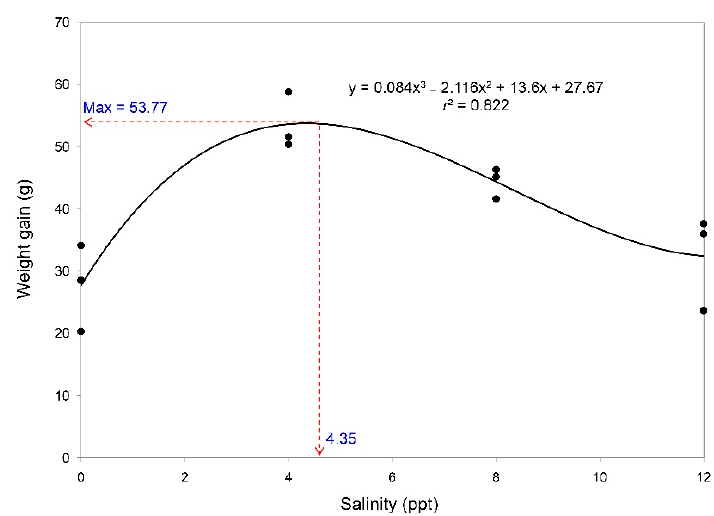
Figure 1. A polynomial regression fit to salinity level affecting the weight gain of northern river terrapins by the end of an eight-week experiment. Each point represents the average from three replicate groups of four subjects. Table 1. Survival, growth performance, and feed utilization of northern river terrapins reared in various salinities. The observed parameters were recorded at the end of the 8-week experiment. Parameter Salinity (ppt) p -Value